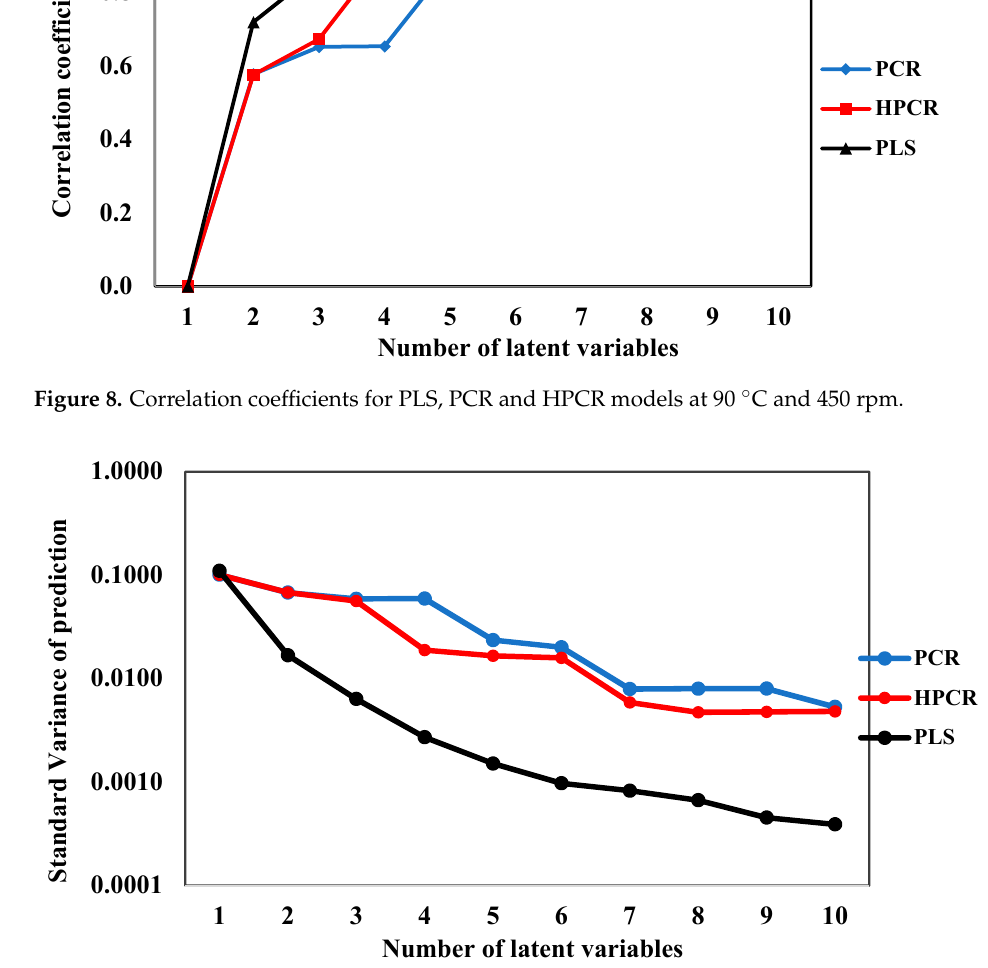
Figure 9. Standard variances of prediction for PLS, PCR and HPCR models at 90 °C and 450 rpm.